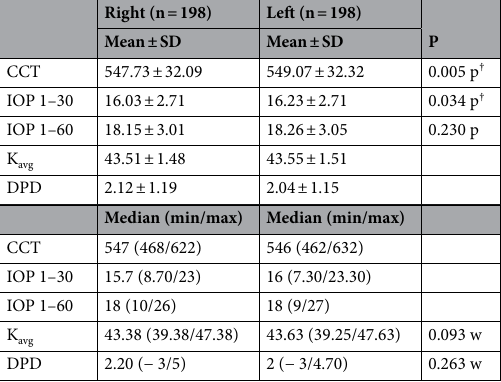
Table 2. Ocular features of the study population and eye laterality results. p paired samples T test (bootstrap), w Wilcoxon sign ranks test (Monte Carlo), SD standard deviation, min minimum, max maximum, IOP 1–30 intraocular pressure in mm Hg (1–30 mode), IOP 1–60 intraocular pressure in mm Hg (1–60 mode), DPD differential pressure difference in mm Hg, K avg average keratometric value in diopters, CCT central corneal thickness in micrometers.